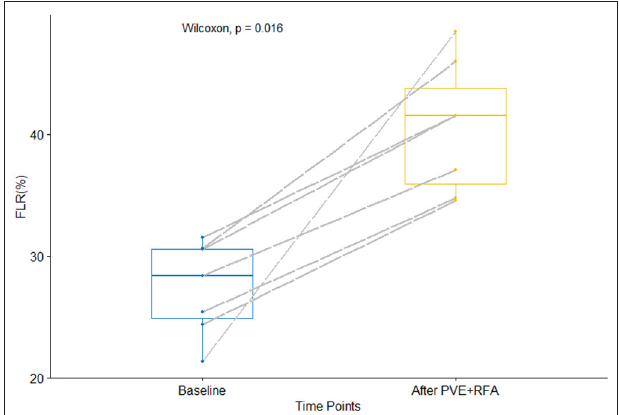
FIGURE 2 | The volume of the future liver remnant in % of standardized total liver volume (sTLV), before and after sequential portal vein embolization (PVE) and radiofrequency ablation (RFA) (PVE + RFA) ( p < 0.05).